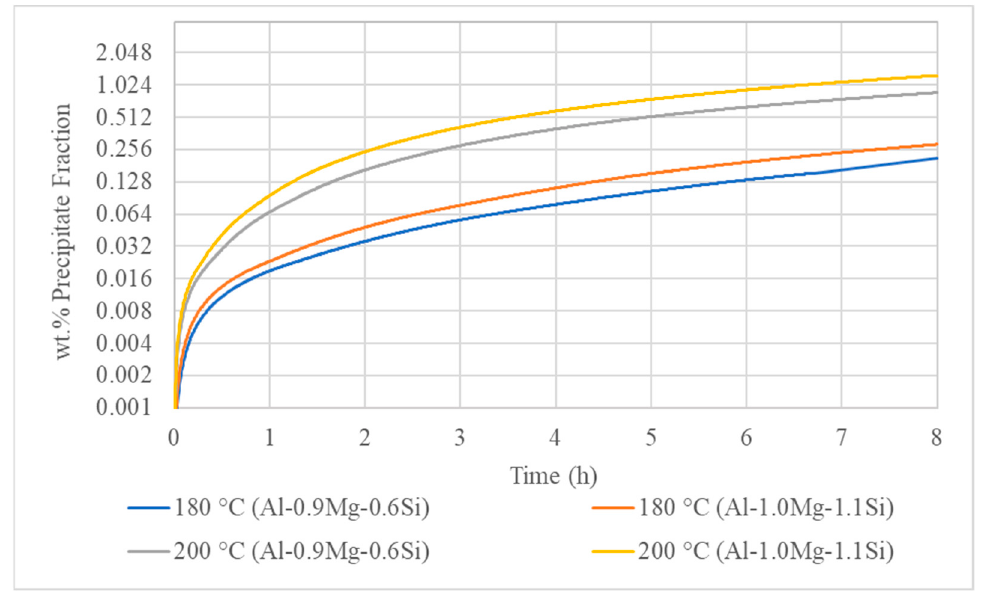
Figure 8. Temporal evolution of the precipitate fraction.